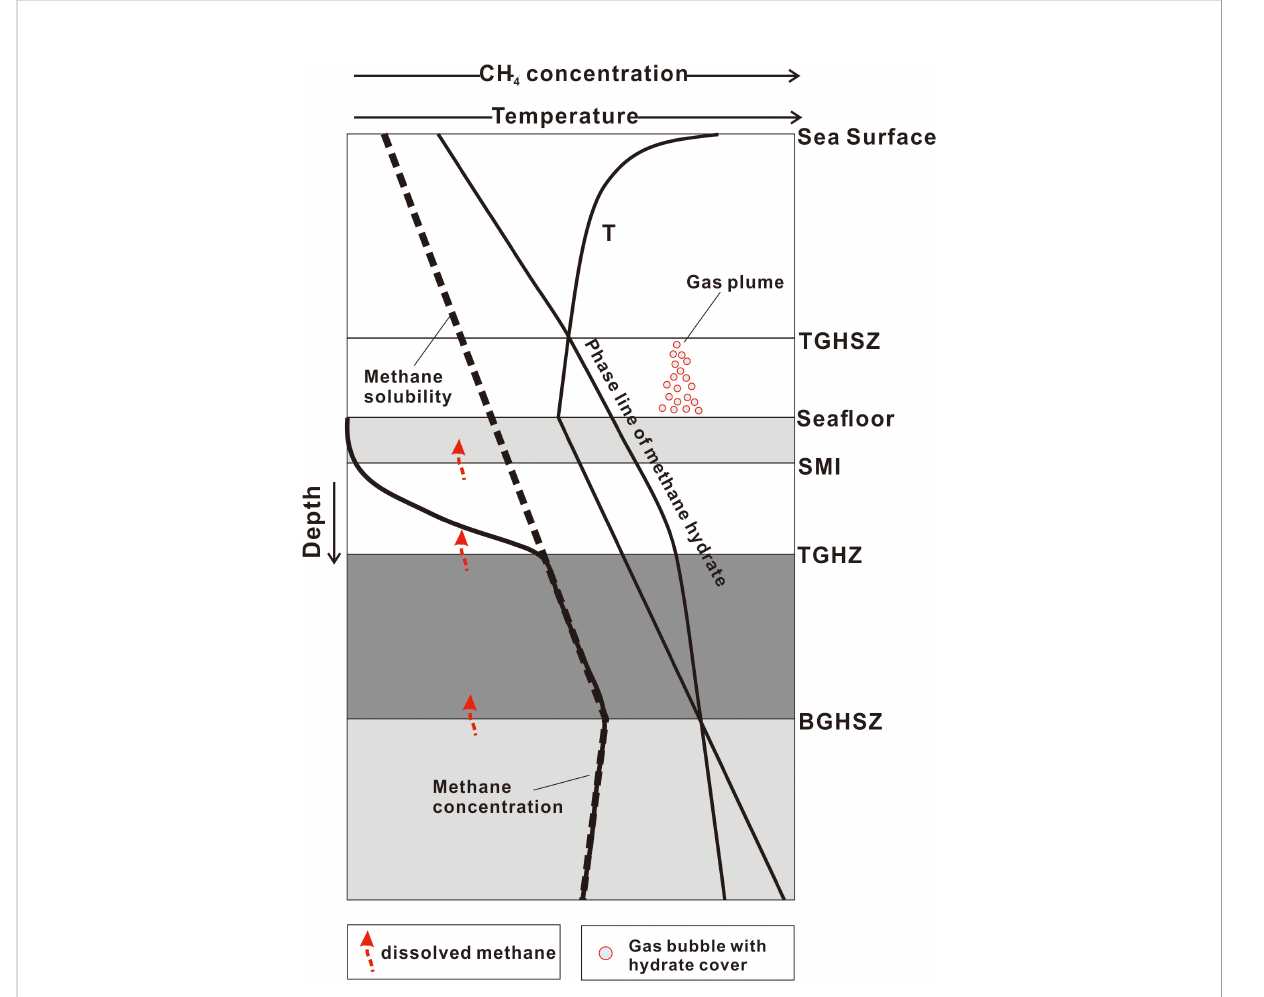
FIGURE 1 Conceptual pro fi le of dissolved methane concentration and solubility [modi fi ed from Xu and Ruppel (1999)]. The two solubility curves intersect at the base of gas hydrate stability zone (BGHSZ). TGHSZ, top of gas hydrate stability zone; SMI, sulfate-methane interface; TGHZ, top of gas hydrate zone. Thicknesses of each layer are not to